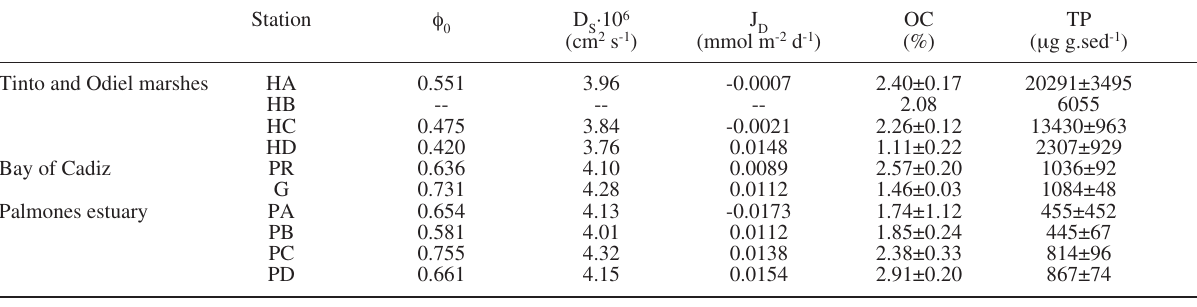
), diffusion coefficient (D ) and diffusive fluxes (J ), at each station. Corresponding organic 0 S D carbon (OC) and total phosphorus (TP) contents of surface sediment are also shown.